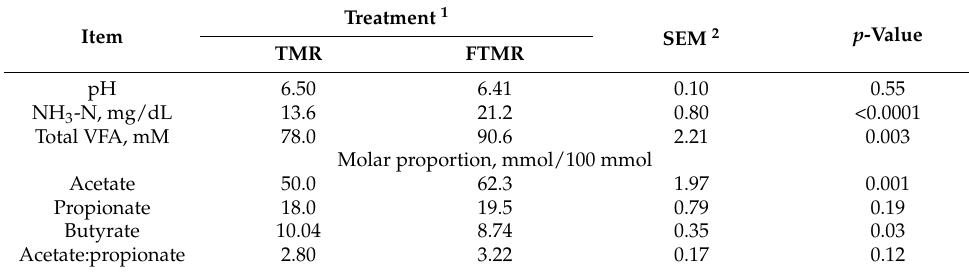
Table 2. Rumen fermentation parameters between the TMR and FTMR in dairy cows. Item